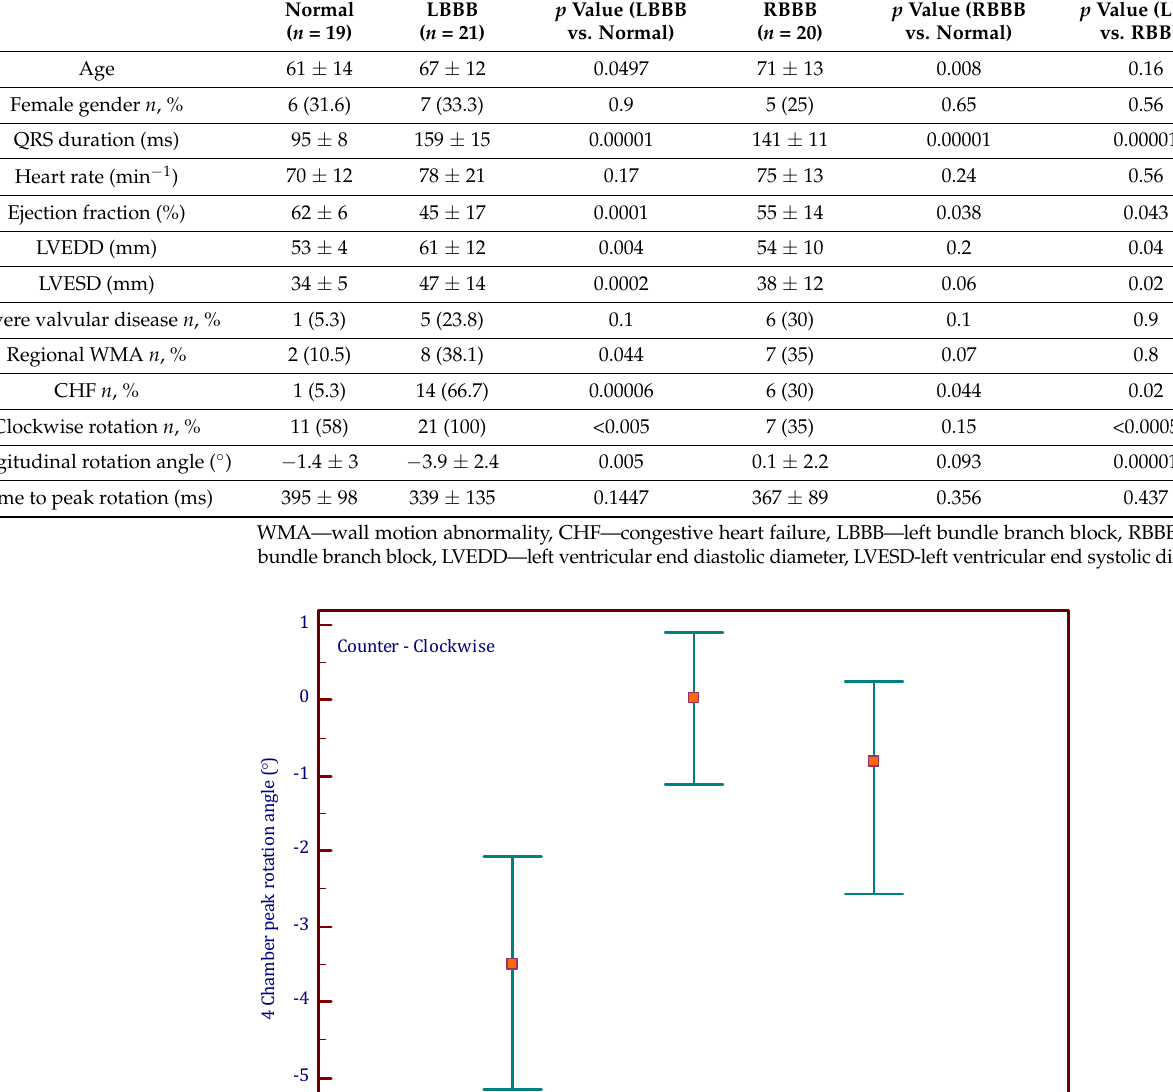
segment (in pink color) was excluded from analysis. The dotted lines represent the average rotation curve. ( A )—Normal QRS duration, no conduction delay. Note the minimal clockwise rotation. ( B )—CLBBB pattern. Definite and extensive longitudinal clockwise rotation. ( C )—CRBBB pattern. Definite and extensive longitudinal counterclockwise rotation. This rotation pattern was variable among patients with CRBBB. Table 1. Clinical and echocardiographic data.